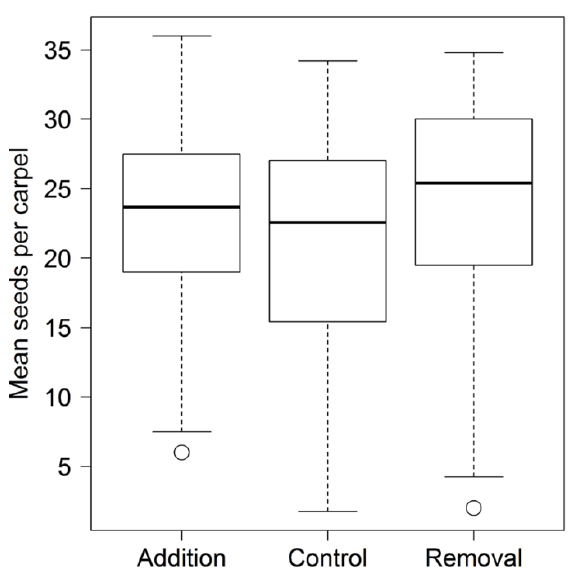
F IGURE 1: Relationship between treatment carrion levels and pollination success (seeds per carpel of emasculated fruit). No significant treatment effect was found. Treatments are carrion addition (A), control (C), and carrion removal (R). Sample sizes (A, C, R order) are: OHV (18, 21, 15); UQV (25, 15, 23); BM